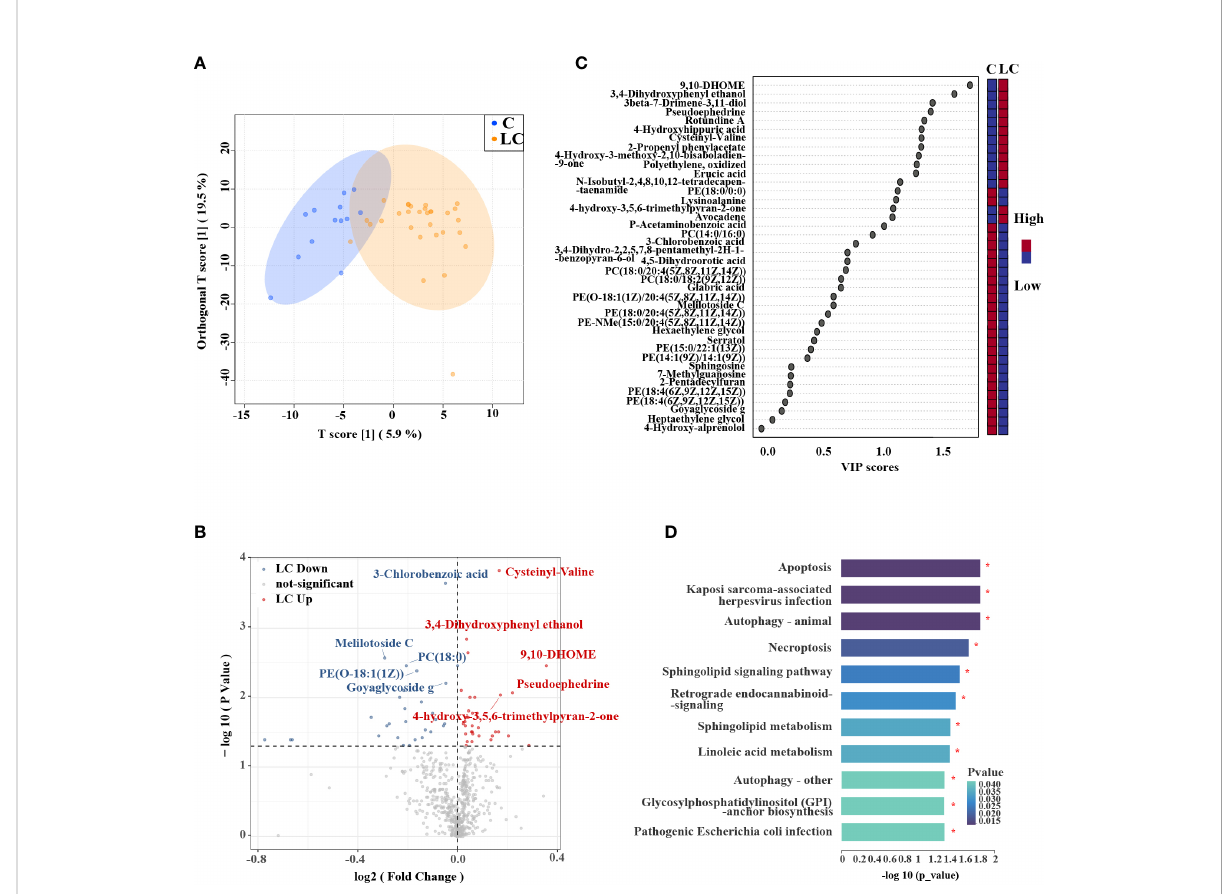
FIGURE 1 Metabolic pro fi les in LC patients and controls. (A) OPLS-DA showed that LC patients and controls were separated into two distinct clusters. (B) Volcano plot of metabolites of LC patients compared to controls. The y-axis represented p-value converted to negative log 10 scale and the x- axis represented log2 fold change. (C) Variable Importance in Projection (VIP) plot generated from the OPLS-DA analysis showed the most discriminative metabolites in descending order of importance. (D) KEGG pathway enrichment analysis of signi fi cantly different metabolites showed that there were 11 pathways had signi fi cant